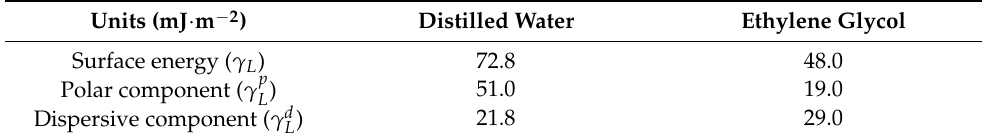
Table 1. Surface energies and polar and dispersive components of distilled water and ethylene glycol